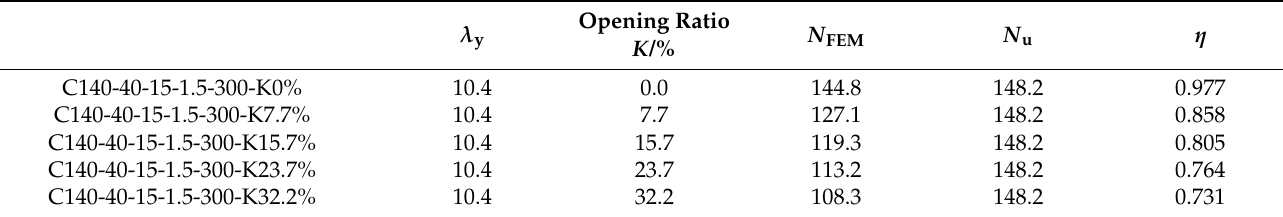
Table A3. Comparison of opening ratio and reduction factor of combined